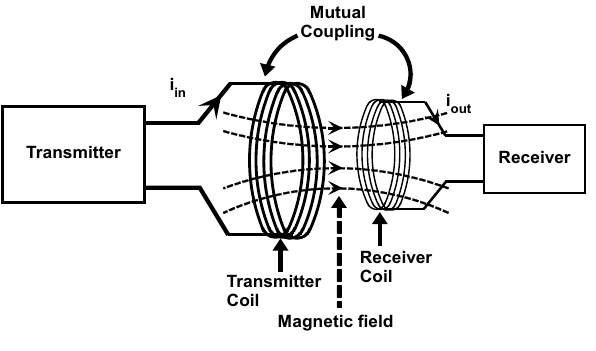
Figure 1: Overview of the ICPT